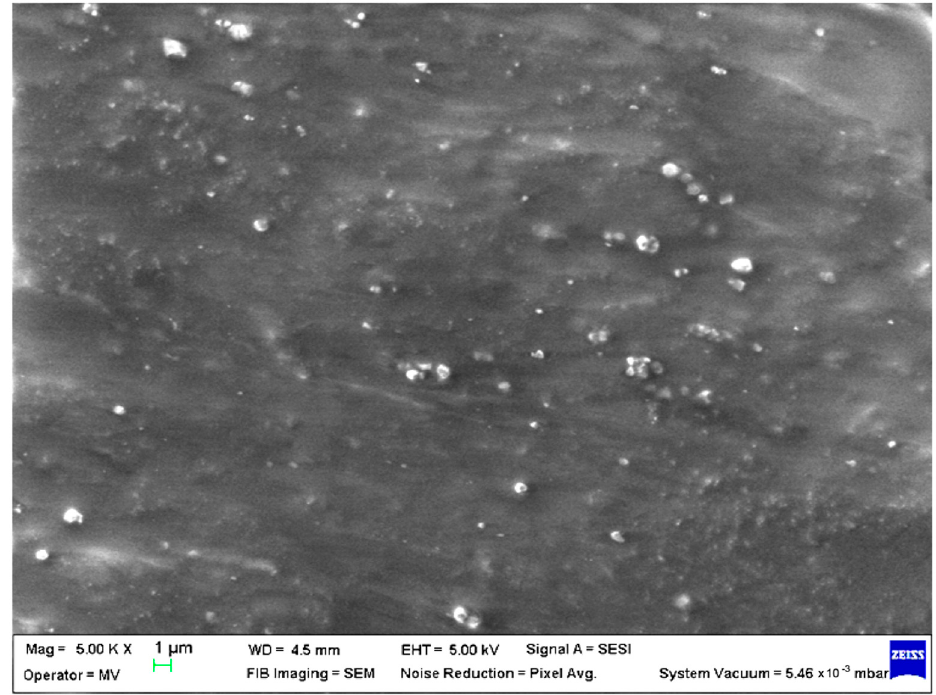
Figure 2. SEM micrographs of PET–Al composite (M2) sample at T 0 (1 μ m scale).